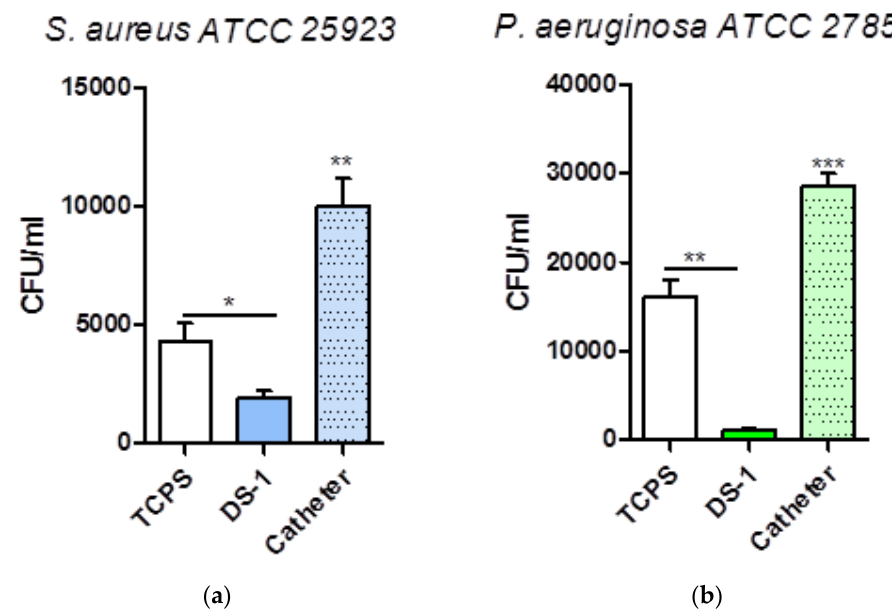
Figure 5. Strains adherence of S. aureus and P. aeruginosa (ATCC strains) to electrospun polyimide fibers. ( a ) note; ( b ) note.